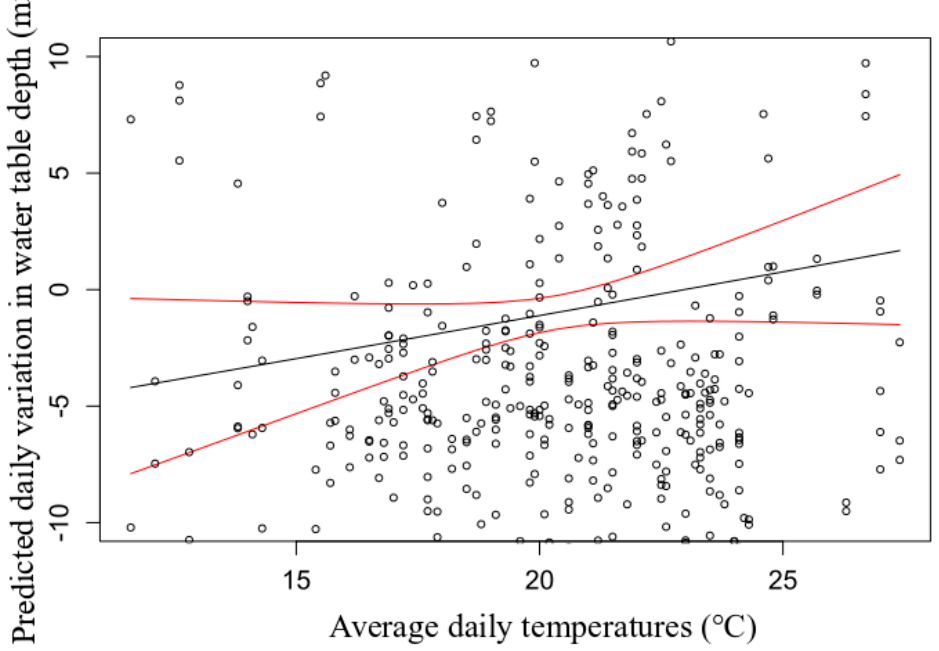
Figure 7. Predicted daily variation in water table depth after silvicultural treatment, based upon average daily temperatures. Model-averaged predictions using the entire set of candidate models are included in 95% CI. Open circles correspond to the original observations. Note that in this figure, daily variation in water table depth was back-transformed from square-root values. The figure shows the effect of variables having the greatest influence on the response variable.